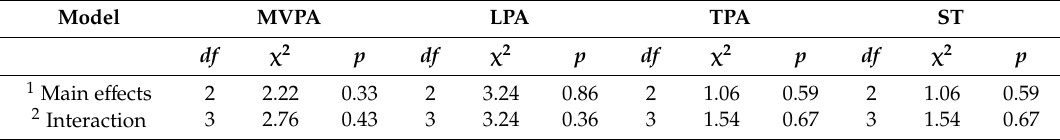
Table 3. The e ff ect of the SPACE extension on MVPA, LPA, TPA, and ST. Model